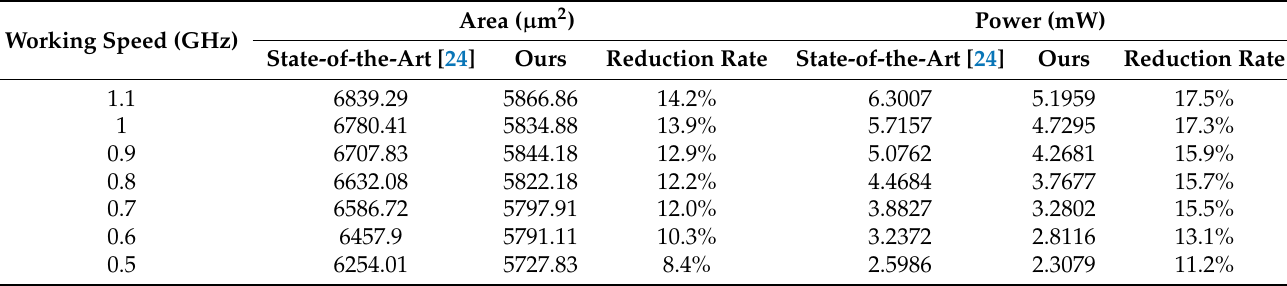
Table 3. Comparisons on different 2 × 2 convolver designs.